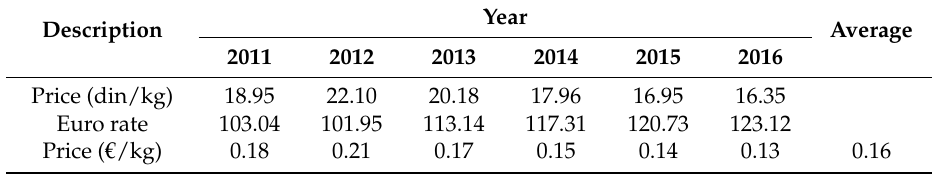
Table 8. The purchase price of barley.